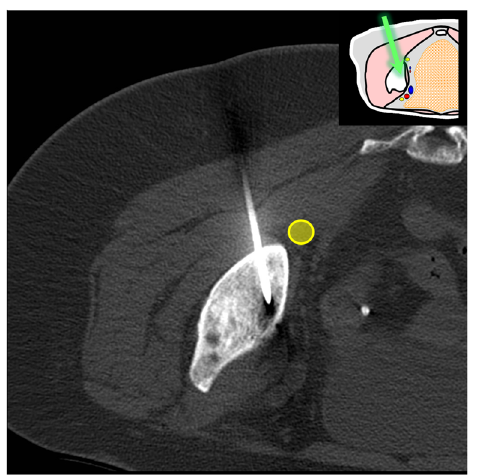
Fig. 12 A 70-year-old woman followed-up for a breast carcinoma pre- senting with new blastic lesions. A posterior approach to the acetabular roof was used. The biopsy with an 11-G bone biopsy needle confirmed breast carcinoma metastasis. A cementoplasty was performed at the same time through the coaxial needle to relieve the pain (not